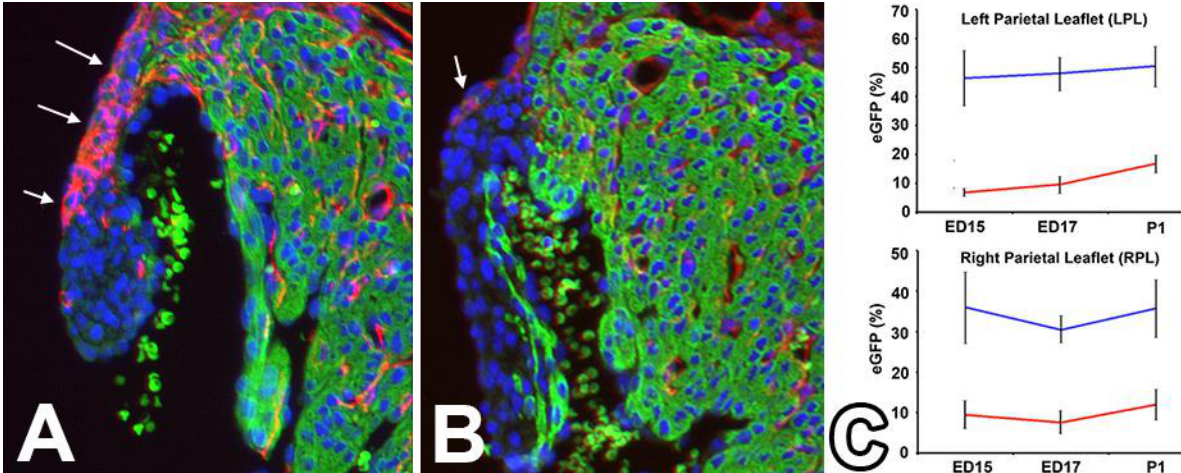
Figure 9. Contribution of EPDCs to the posterior leaflet of the mitral valve of control ( A ) and WT1 cre ;ALK3 fl/fl ;R26 mG ( B ) hearts at ED17. The sections in panels ( A , B ) were stained for EGFP (immunolocalized and visualized in the red channel) to localize EPDCs, the myocardium (myosin heavy chain in green), and DAPI to visualize all nuclei. Panel ( C ) shows a graph with the percentage of EGFP-positive cells (determined using AMIRA 3D software), in the left and right parietal leaflets of ED15, ED17, and postnatal day 1 (P1) hearts. The blue line represents percentage of EGFP-positive cells in control hearts, the red line represents this percentage in the heart of WT1 cre ;ALK3 fl/fl ;R26 mG specimens (adapted from Lockhart et al., 2014).